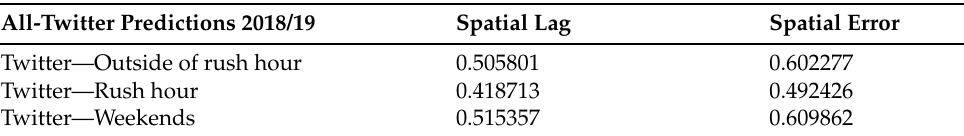
Table 4. Explanatory power of subsets from the 2018/19 Twitter data predicting Twitter street segment loads for the entire study